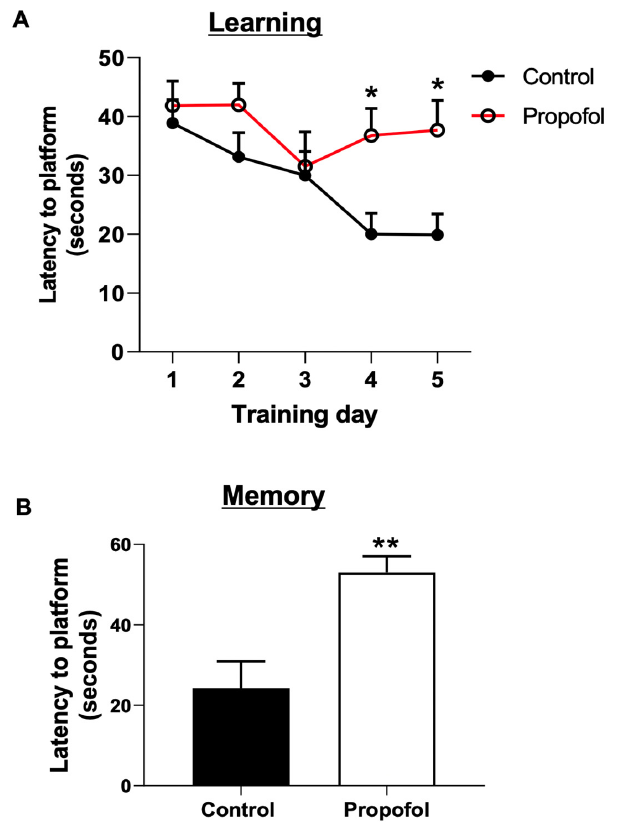
Figure 2. Morris water maze test revealed that P7 propofol exposure resulted in impairments in learning and memory in P60 mice. ( A ) The latency of propofol-exposed mice was longer than control mice at day 4 and 5 of learning tests. ( B ) The developmentally propofol-exposed P60 mice took longer time to find the platform at day 6 of memory test compared with control mice. n = 12, * p < 0.05, ** p < 0.01.